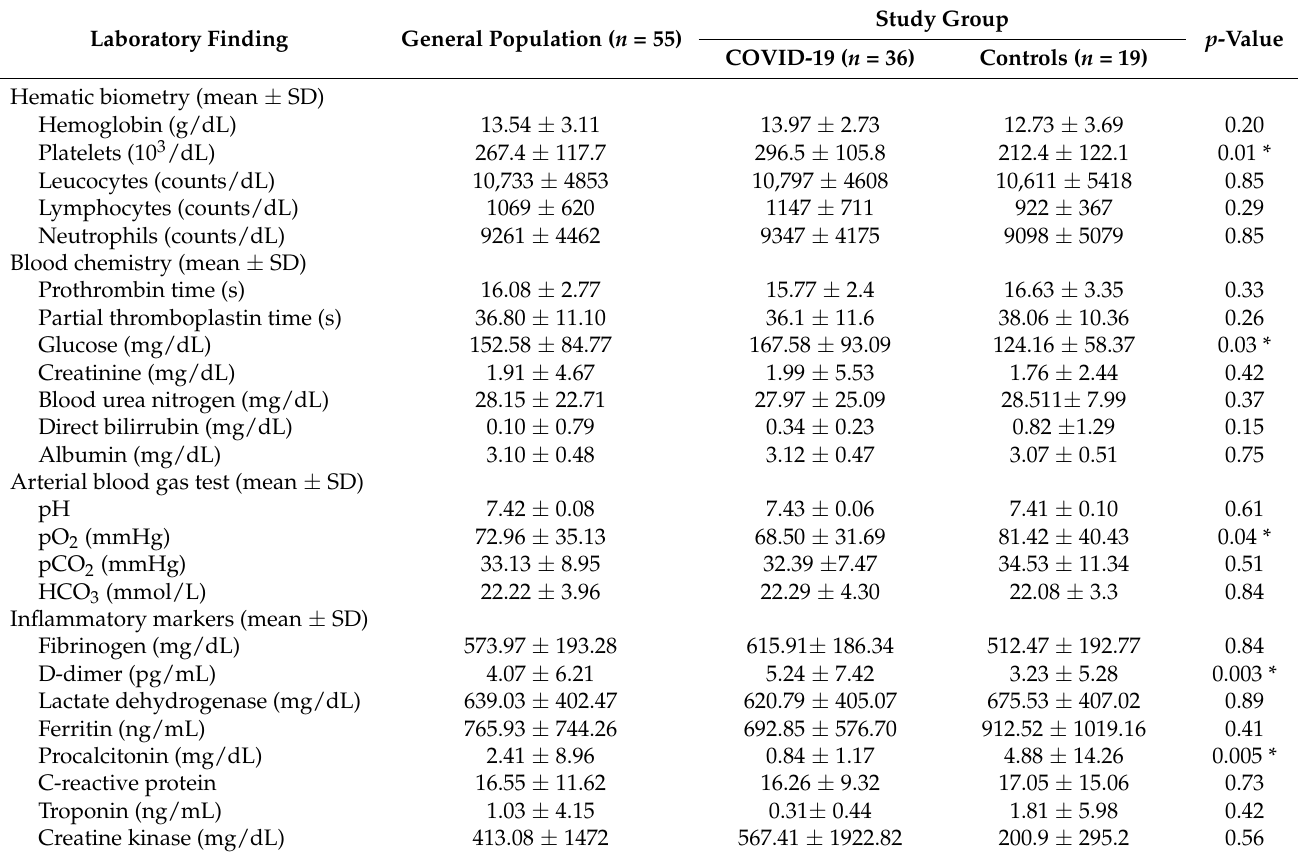
Table 2. Laboratory findings of the study groups at the time of hospital